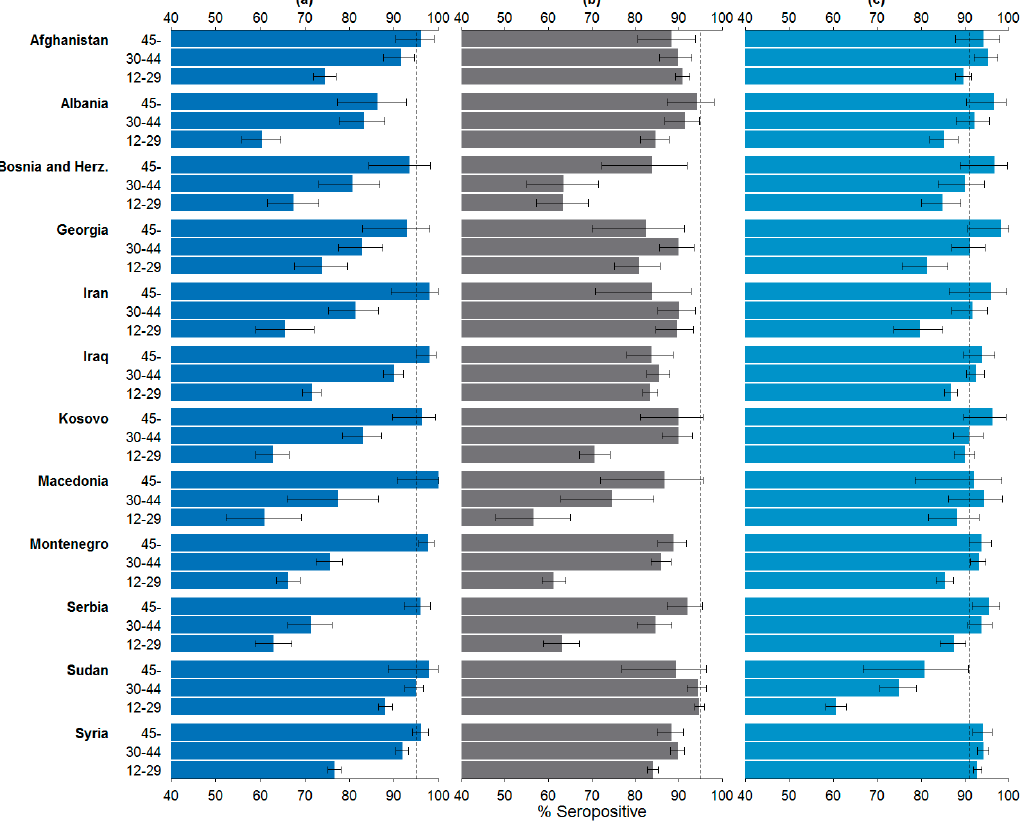
Figure 2. Seroprevalence by country of origin and age group (12–29 years, 30–44 years, 45 years and older) with 95% confidence intervals: ( a ) Measles; ( b ) Rubella; ( c ) Varicella. The dotted lines mark the herd immunity thresholds (95% for measles and rubella, 91% for varicella [8–11]).